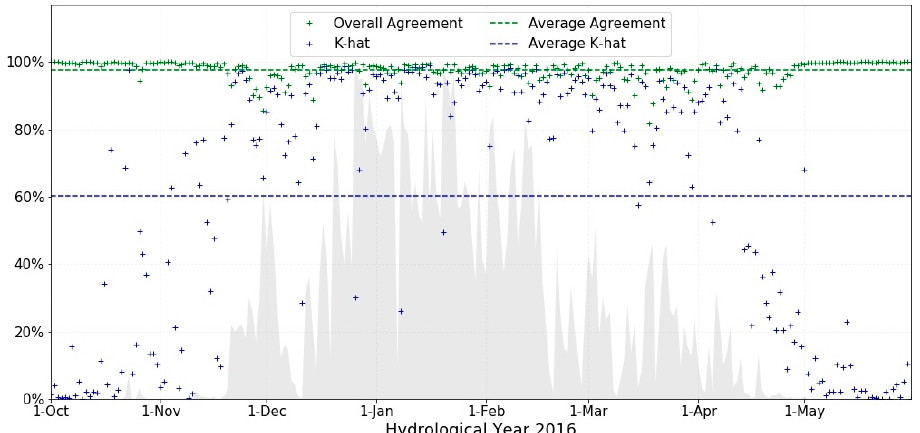
Figure 7. Marker plots showing Overall Agreement and Kappa statistics between MODIS and VIIRS snow maps with respect to each day of the 2016 hydrological year. The green and blue dash lines respectively represent the average overall agreement (97.67%) and average Kappa statistics (0.601) between MODIS and VIIRS snow maps. The gray area represents the percentage of cells mapped by both MODIS and VIIRS as snow each day.